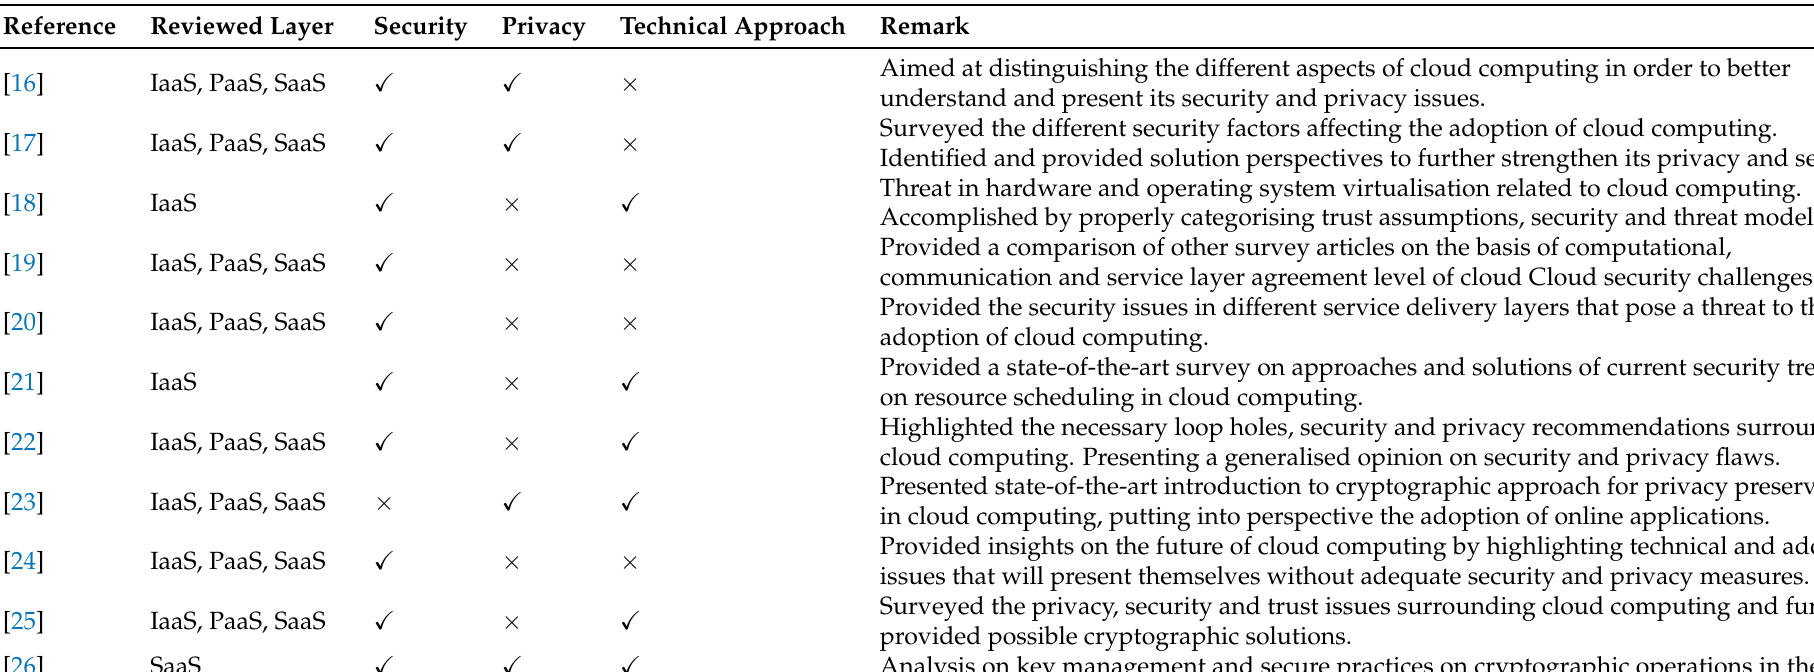
Table 3. Review of literature